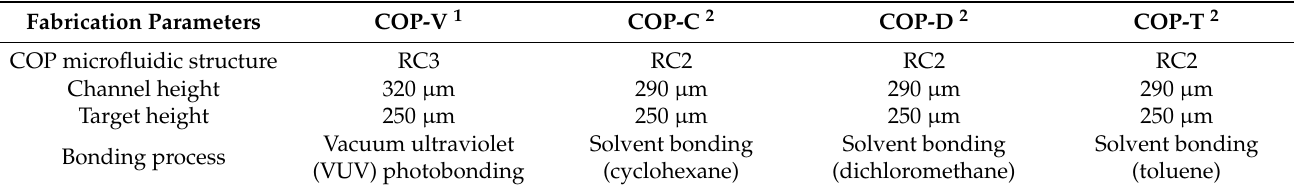
Table 2. Summary of cyclo-olefin polymer (COP) microfluidic structures, target heights, and bonding processes. Fabrication